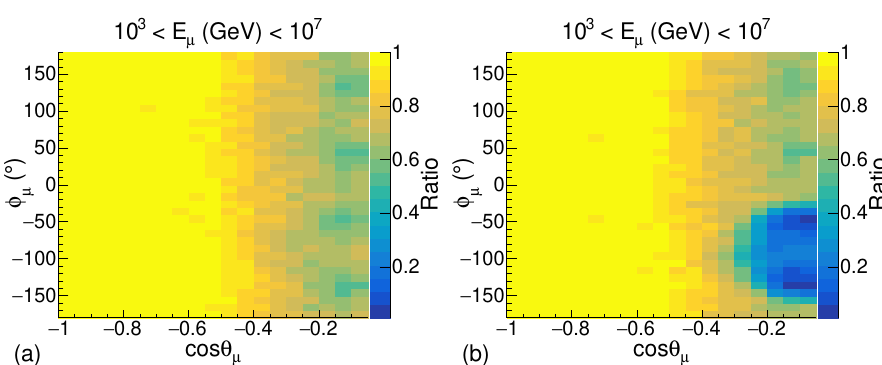
Figure 7. The ratio of the number of muons detected to the number of muons generated in the simulation with the entire energy range with respect to the muon arrival direction. ( a ) Without Shore ( b ) With